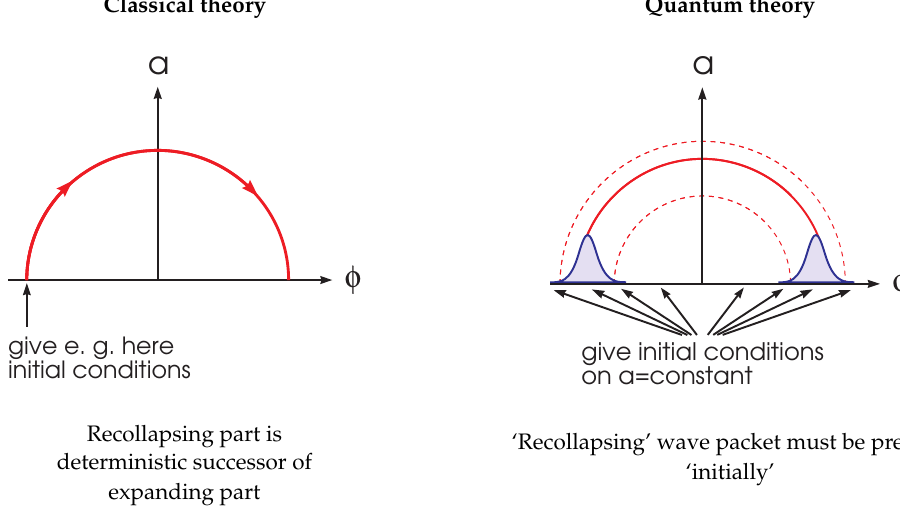
Figure 3. Comparison between classical trajectory and the quantum wavefunction for a classically expanding and collapsing